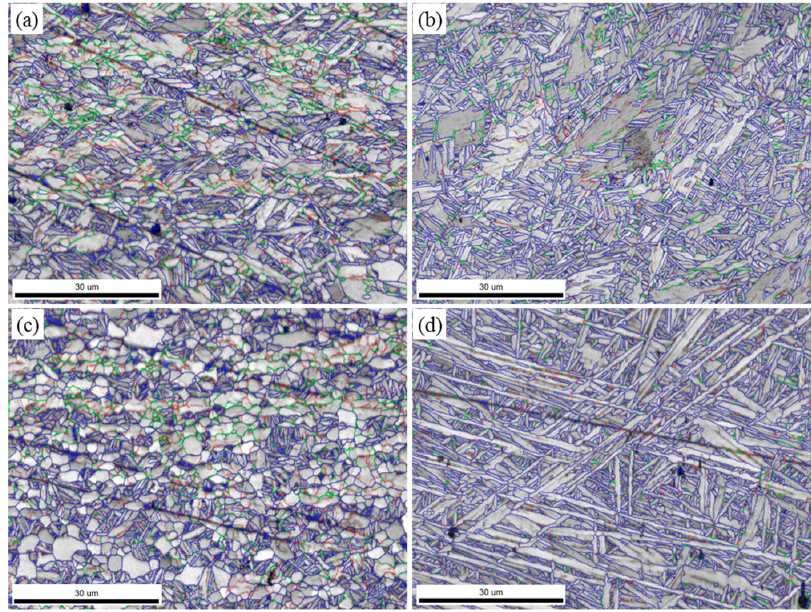
Figure 11. EBSD (image quality + grain boundary) maps of: ( a ) HZA, at 900 rpm—10 mm/min ( b ) SZ, at 900 rpm—10 mm/min ( c ) HAZ, at 1100 rpm—10 mm/min ( d ) SZ; at 1100 rpm—10 mm/min.